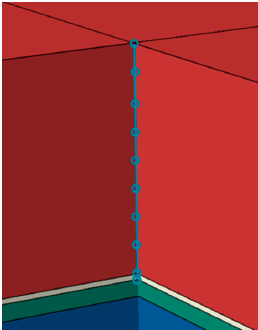
Figure 10. Evaluation points on top of the silicon layer, on top of the copper layer, and on top of each of the eight epoxy layers.